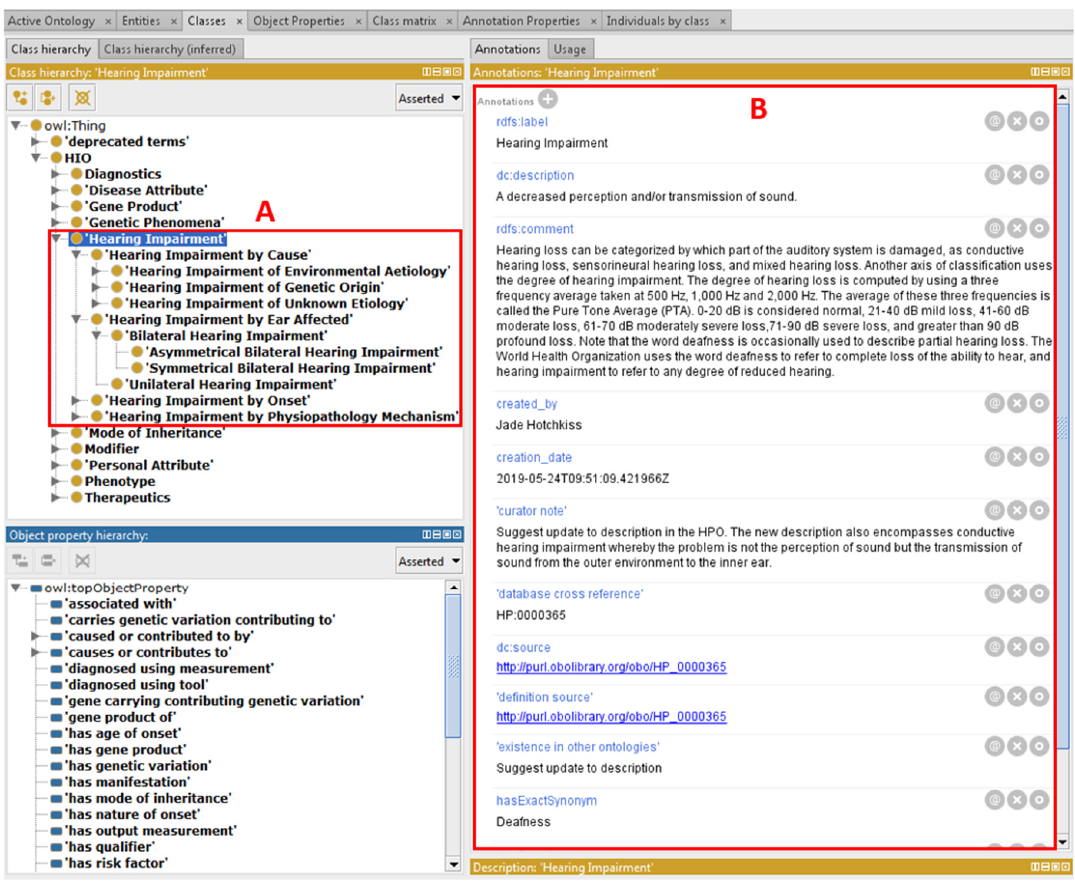
Figure 4. The ‘Hearing Impairment’ class within the HIO. (A) General categorization of hearing impairments in the ‘Hearing Impairment’ upper class and (B) annotations of the ‘Hearing Impairment’ class.